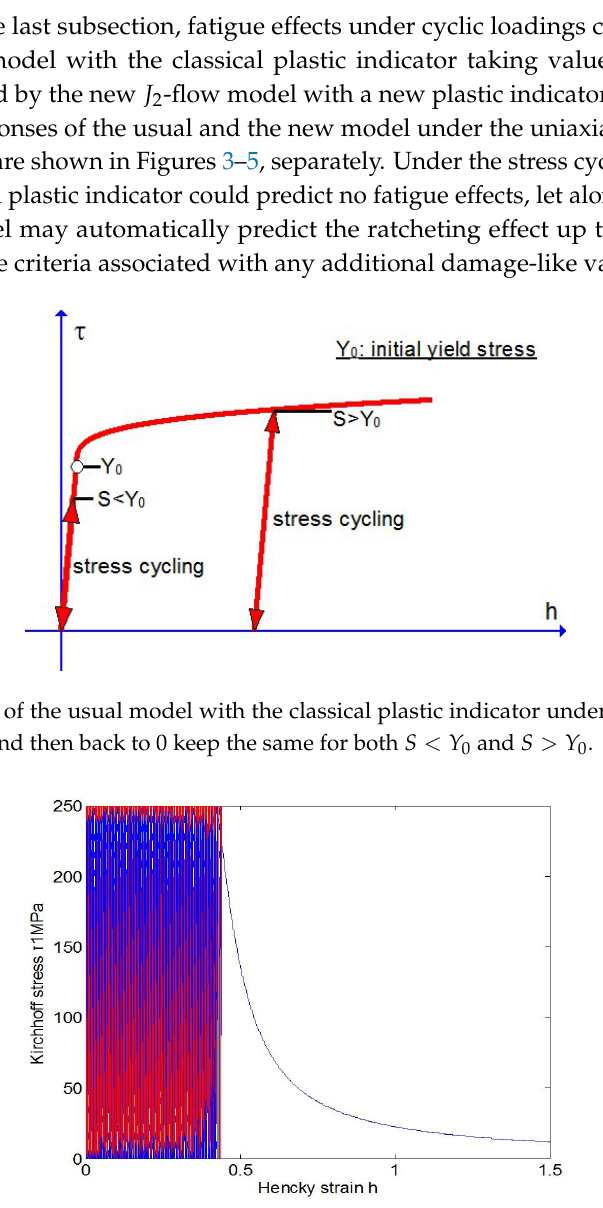
Figure 4. Ratcheting response of the new model with the plastic indicator Equation (16) under uniaxial stress cycling from 0 to 250 MPa and then back to 0, in which a critical failure state is reached at the number of 4032